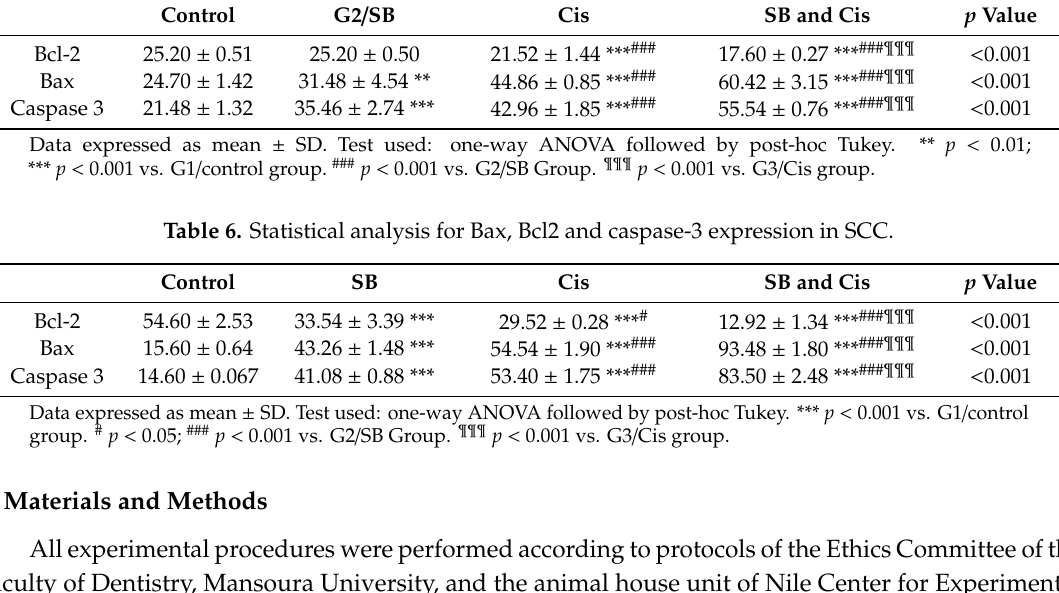
Table 5. Statistical analysis for Bax, Bcl2 and caspase-3 expression in GMSCs. Control